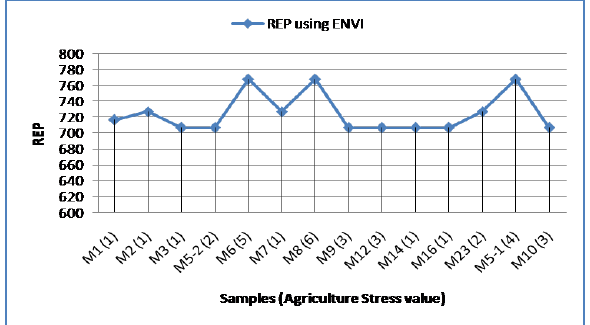
Figure 4: REP for mulberry plants using maximum first derivative method